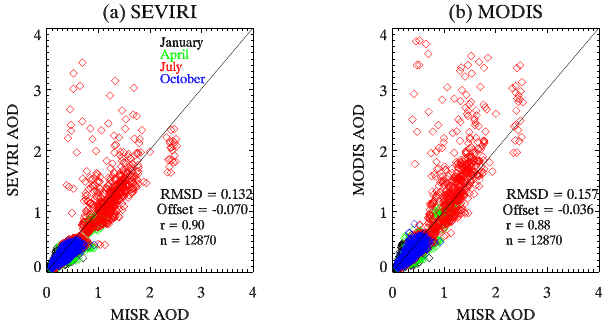
Figure 9. Scatterplots of MISR AOD against SEVIRI and MODIS AODs over the Red Sea (2008–2011). Points are colour coded by